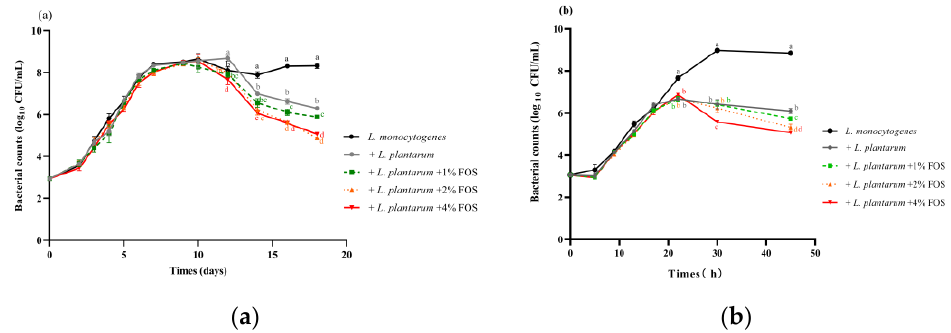
Figure 2. Growth kinetics of L. monocytogenes on L. plantarum combined with 1% ( w / v ) FOS, 2% ( w / v ) FOS, or 4% ( w / v ) FOS in BHI at 10 °C for 18 days ( a ) and at 25 °C for 45 h ( b ). Data represented as log 10 (CFU/mL) are mean values ± SD ( n = 6).